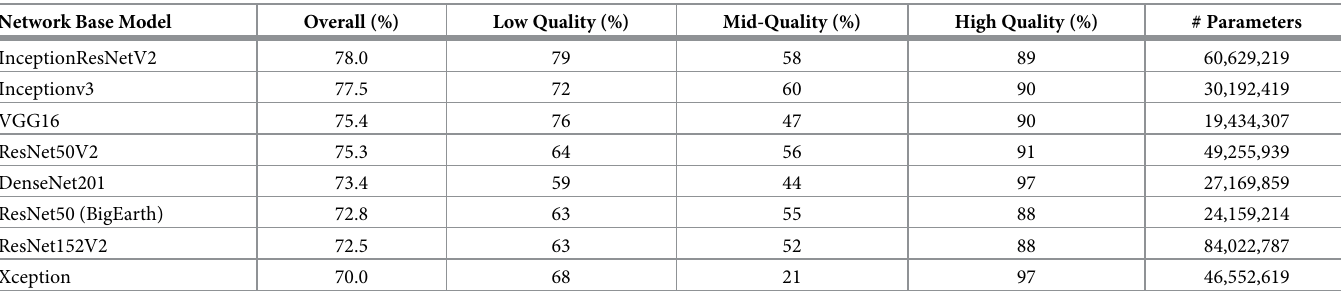
Table 2. Architecture results.